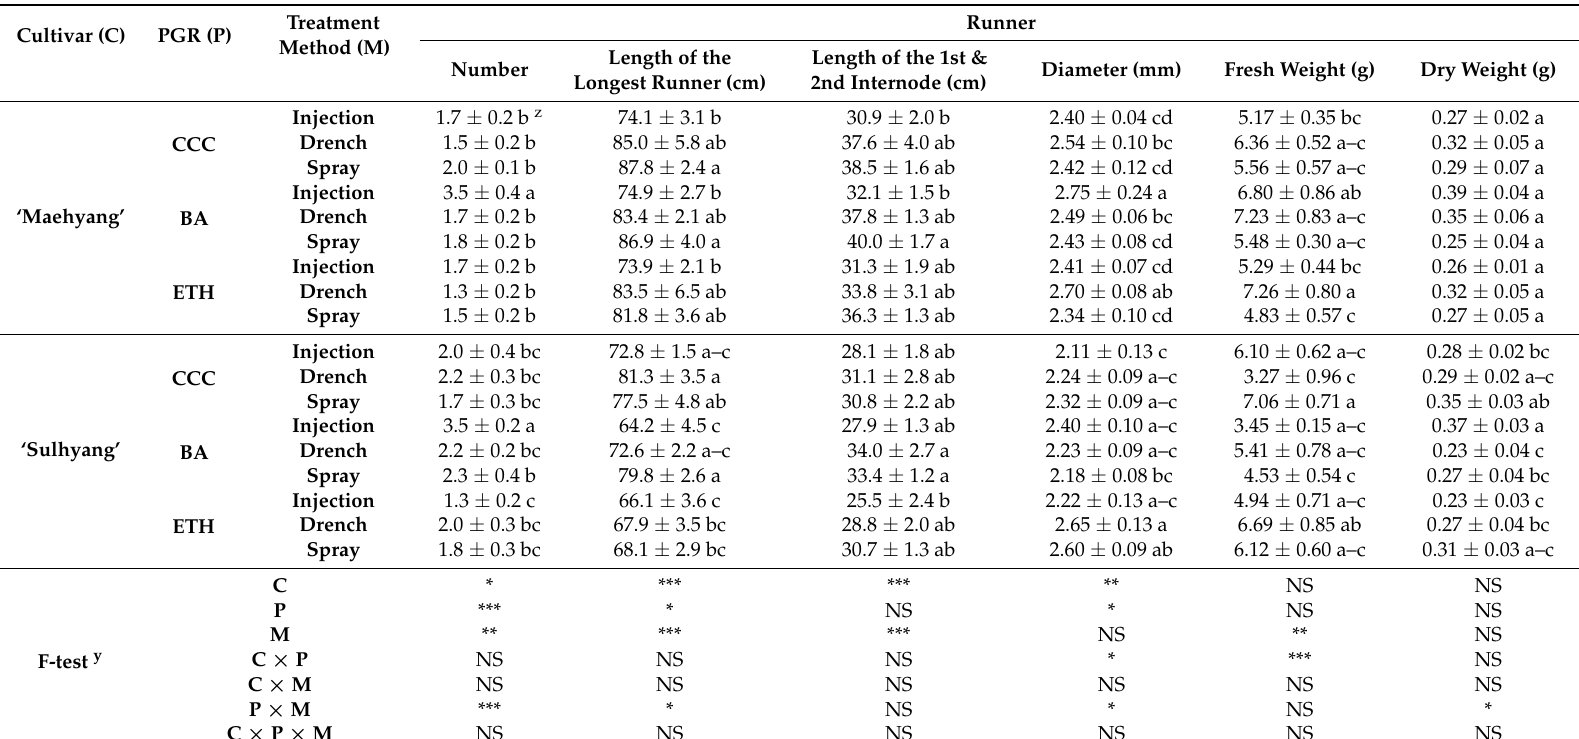
Table 1. Effect of plat growth regulators (PGR) and application method on growth and development of runners of ‘Maehyang’ and ‘Sulhyang’ strawberry measured at 30 days after treatment